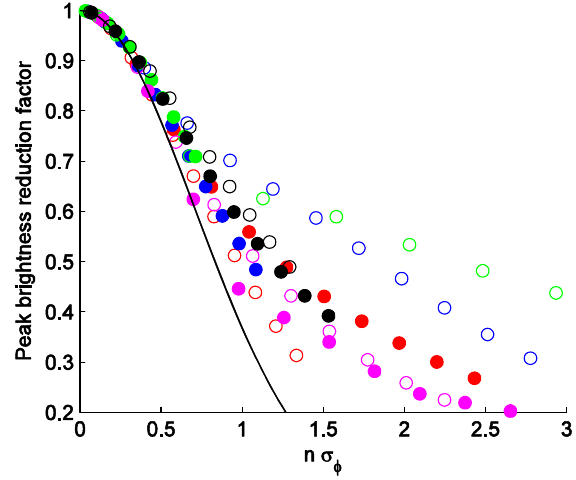
FIG. 21. As Fig. 20 (upper left), with zero electron beam